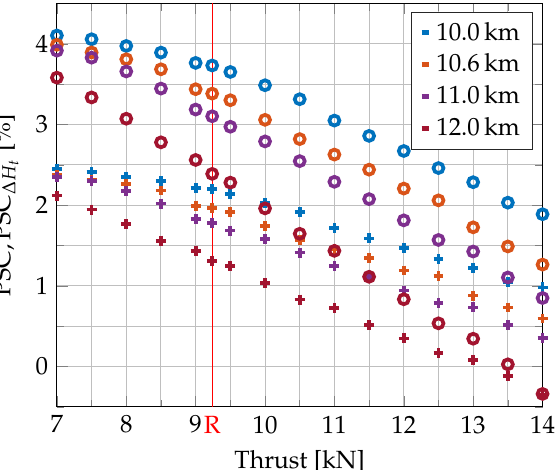
Figure 11. PSC (o) and PSC ∆ H boundary